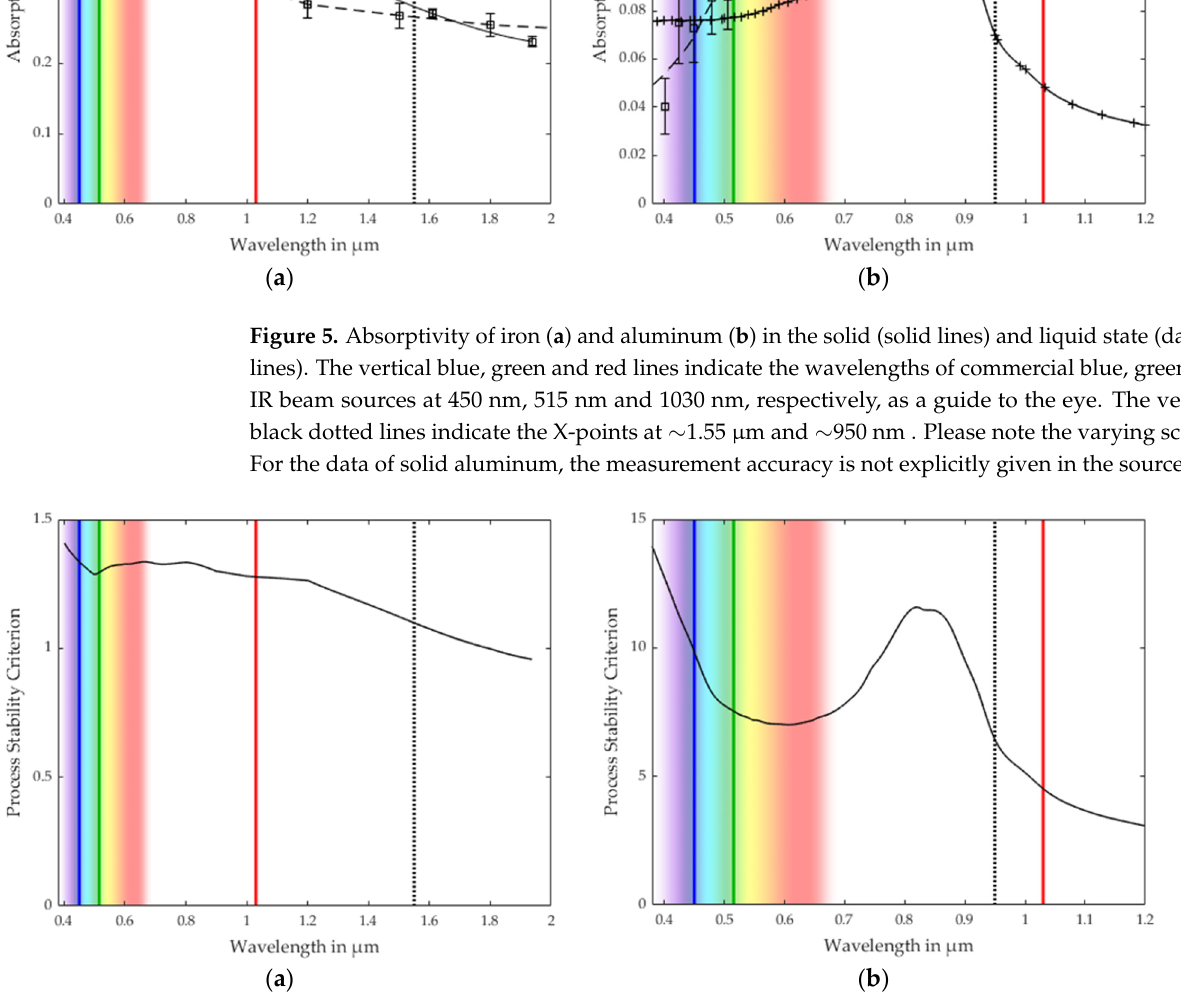
Figure 6. Process stability criterion of iron ( a ) and aluminum ( b ). The vertical blue, green and red lines indicate the wavelengths of commercial blue, green and IR beam sources at 450 nm, 515 nm and 1030 nm, respectively, as a guide to the eye. The vertical black dotted lines indicate the X-points at ~1.55 µm and ~950 nm. Please note the varying scaling.